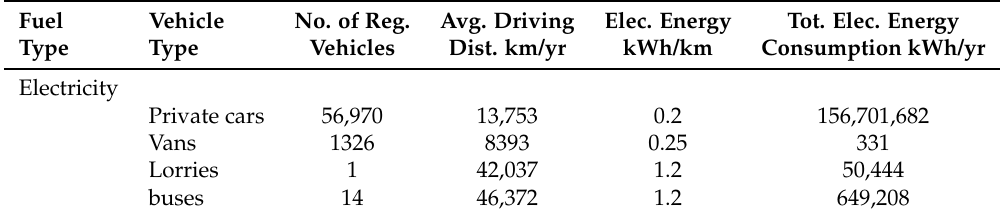
Table 2. Number of registered electric vehicles in the county, driving distance and electricity consumption in 2018 [29,30].